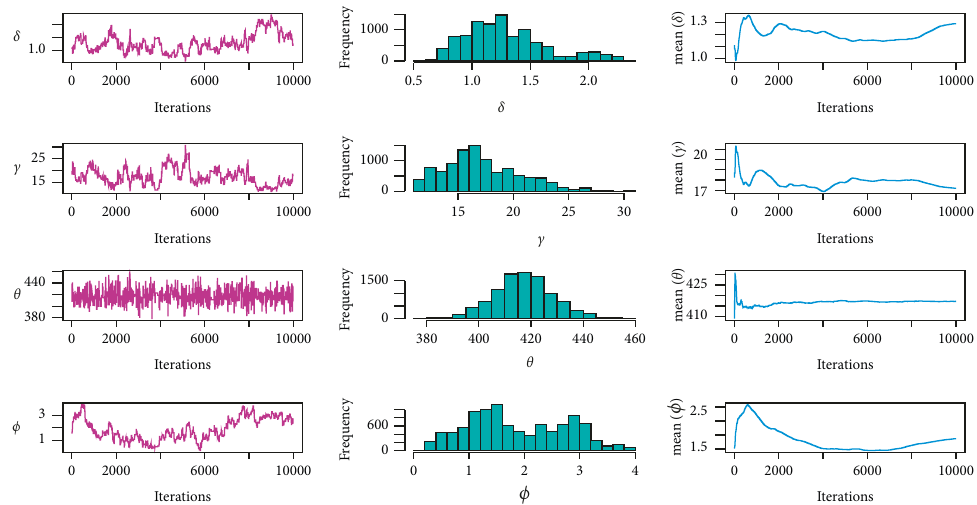
Figure 9: Convergence plots of MCMC for parameter estimates of IELoP distribution for dataset II.